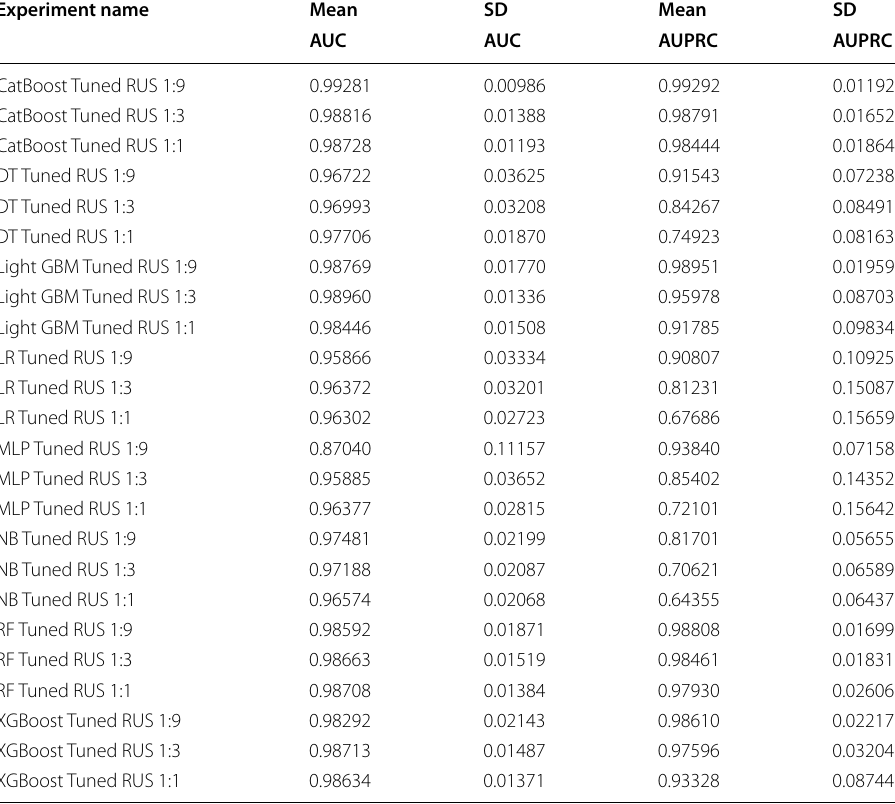
Table 19 Classification results for the data exfiltration dataset with sampling and tuned hyperparameters experiments; mean and standard deviations of AUC and AUPRC, (10 iterations of 5-fold cross-validation)